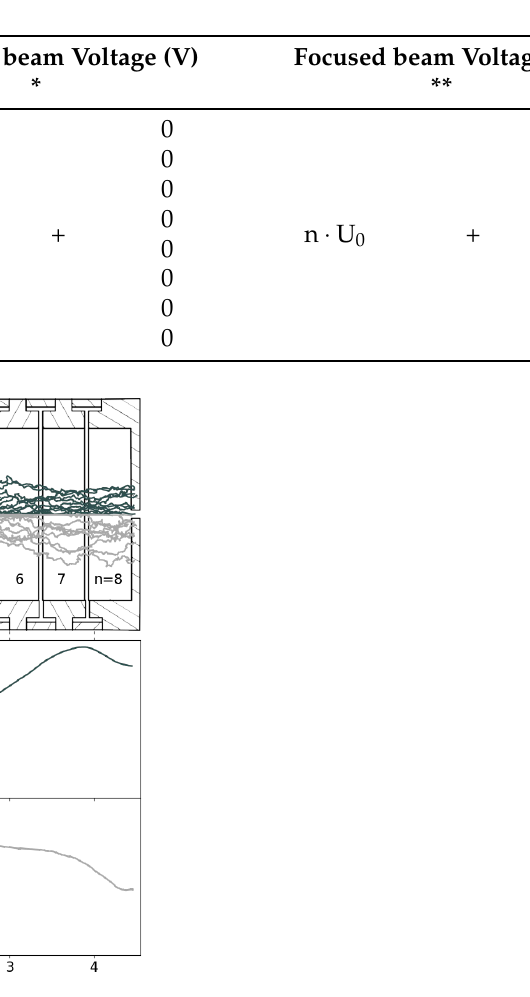
Figure 4. ( a ) Trajectories for E/n 0 = 15 Td for unfocused (*) and focused beams (**). ( b ) Electric fields along the electrodes for focused ( top ) and unfocused ( bottom )